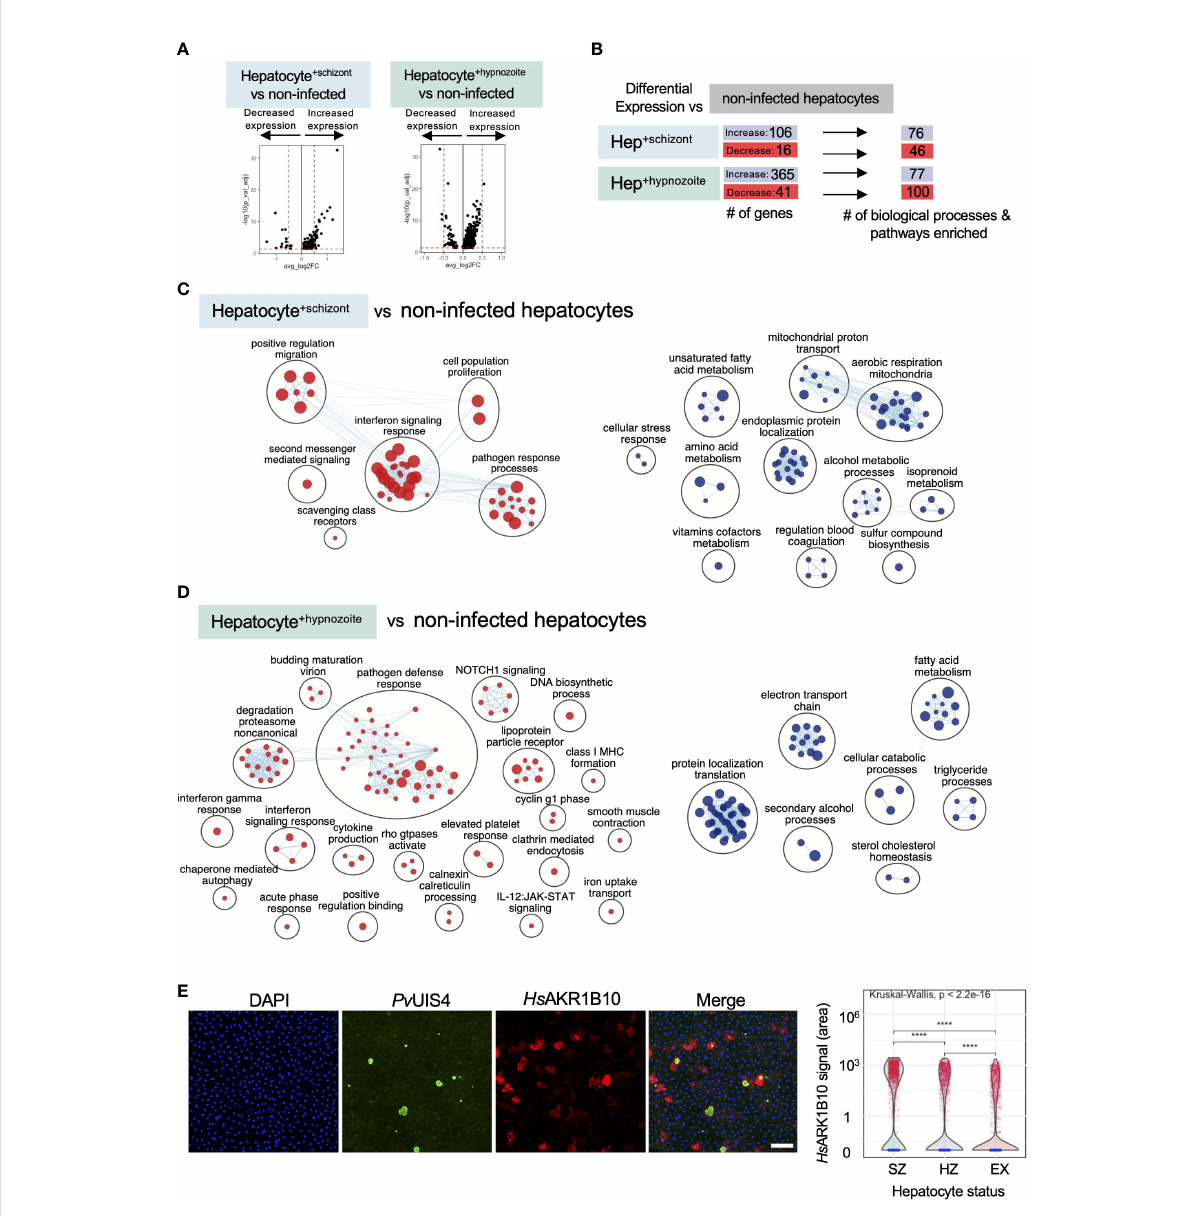
FIGURE 6 Analysis of host transcriptional signatures in P. vivax infected hepatocytes. (A) Volcano plots showing changes in gene expression in infected hepatocytes versus non infected (Wilcoxon rank sum, Bonferroni adjusted p value < 0.05). Positive fold change (FC) values represent genes with greater expression, and negative FC values represent genes with decreased expression. Dashed horizontal red lines: Bonferroni adjusted p value = 0.05; dashed vertical red lines: log 2 FC = 0.5. (B) Summary of differential gene expression data shown in the volcano plots and of the enrichment analyses. Hep: hepatocyte. (C) Enrichment map of cellular processes and pathways associated with hepatocyte infection with P. vivax schizonts. (D) Enrichment map of cellular processes and pathways associated with hepatocyte infection with P. vivax hypnozoites. For the maps depicted in panels C and D, node size is proportional to the number of genes identi fi ed in each gene set (minimum 3 genes/gene set); each node represents a distinct biological process or pathway derived from gene with decreased expression (red) or increased expression (blue) versus non-infected cells; and edges (blue lines) represent the number of genes overlapping between two processes or pathways. (E) a Representative confocal image of P. vivax parasites on day 12 post-infection of hepatocytes (left). Cells were stained with DAPI (blue), Pv UIS4 (green), and Hs AKR1B10 (red). White bar represents 100µm. Violin plot displaying the distribution of AKR1B10 signal in hepatocyte cultures infected with P. vivax (right). SZ: hepatocyte containing schizont; HZ: hepatocyte containing hypnozoite; EX: hepatocyte not infected but exposed to P. vivax. ****: p <= 0.0001, Wilcoxon